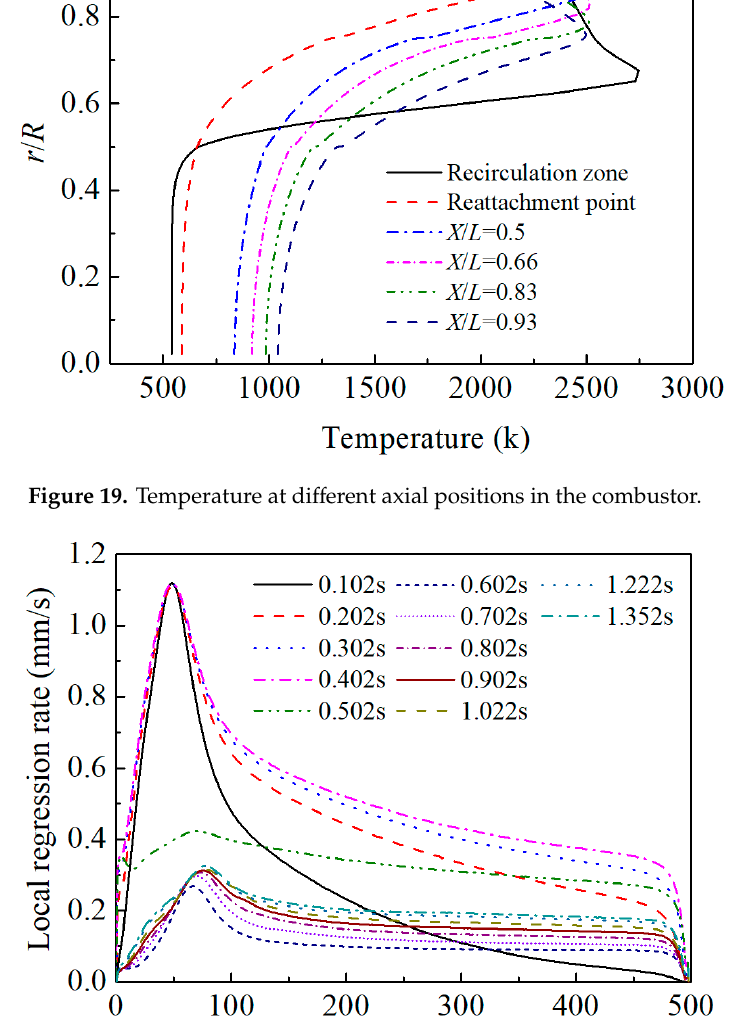
Figure 21. The profiles of local heat flux and regression rate along the solid surface.